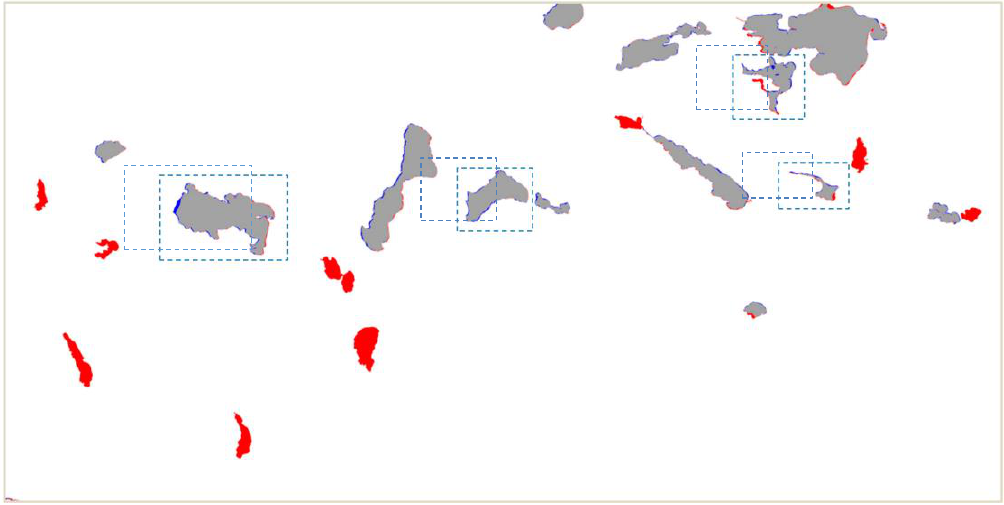
Figure 13. Overlay of the tenth and eleventh levels.